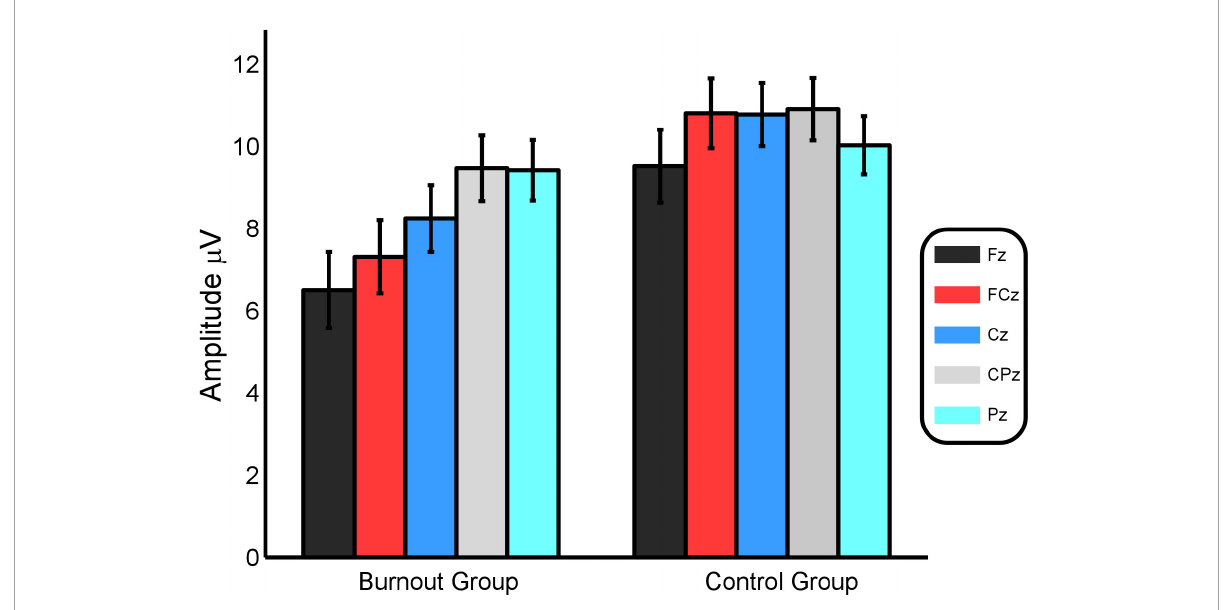
FIGURE2 A comparison of the average P3a amplitudes at the five electrode sites between the burnout group and the control group.